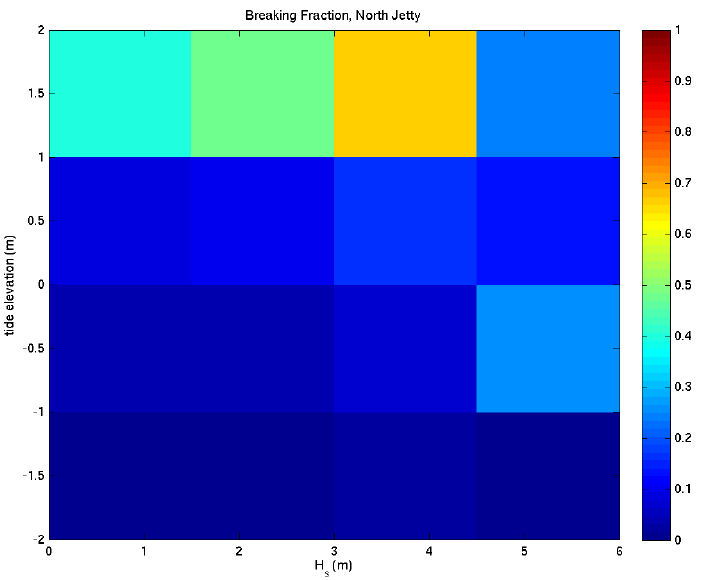
Figure 20. Breaking fraction statistics for the north jetty as a function of wave height and tide eleva- tion.